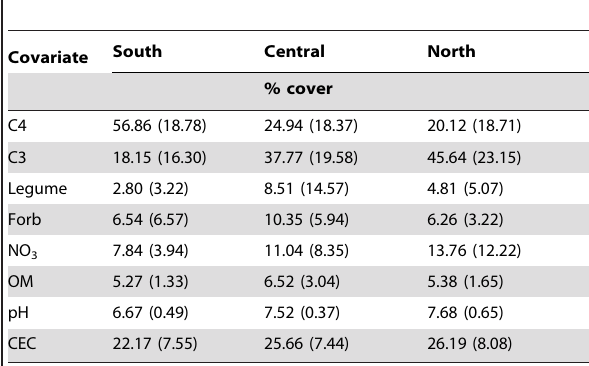
Table 6. Mean values (SD) of covariates by location across all years from conservation grasslands in